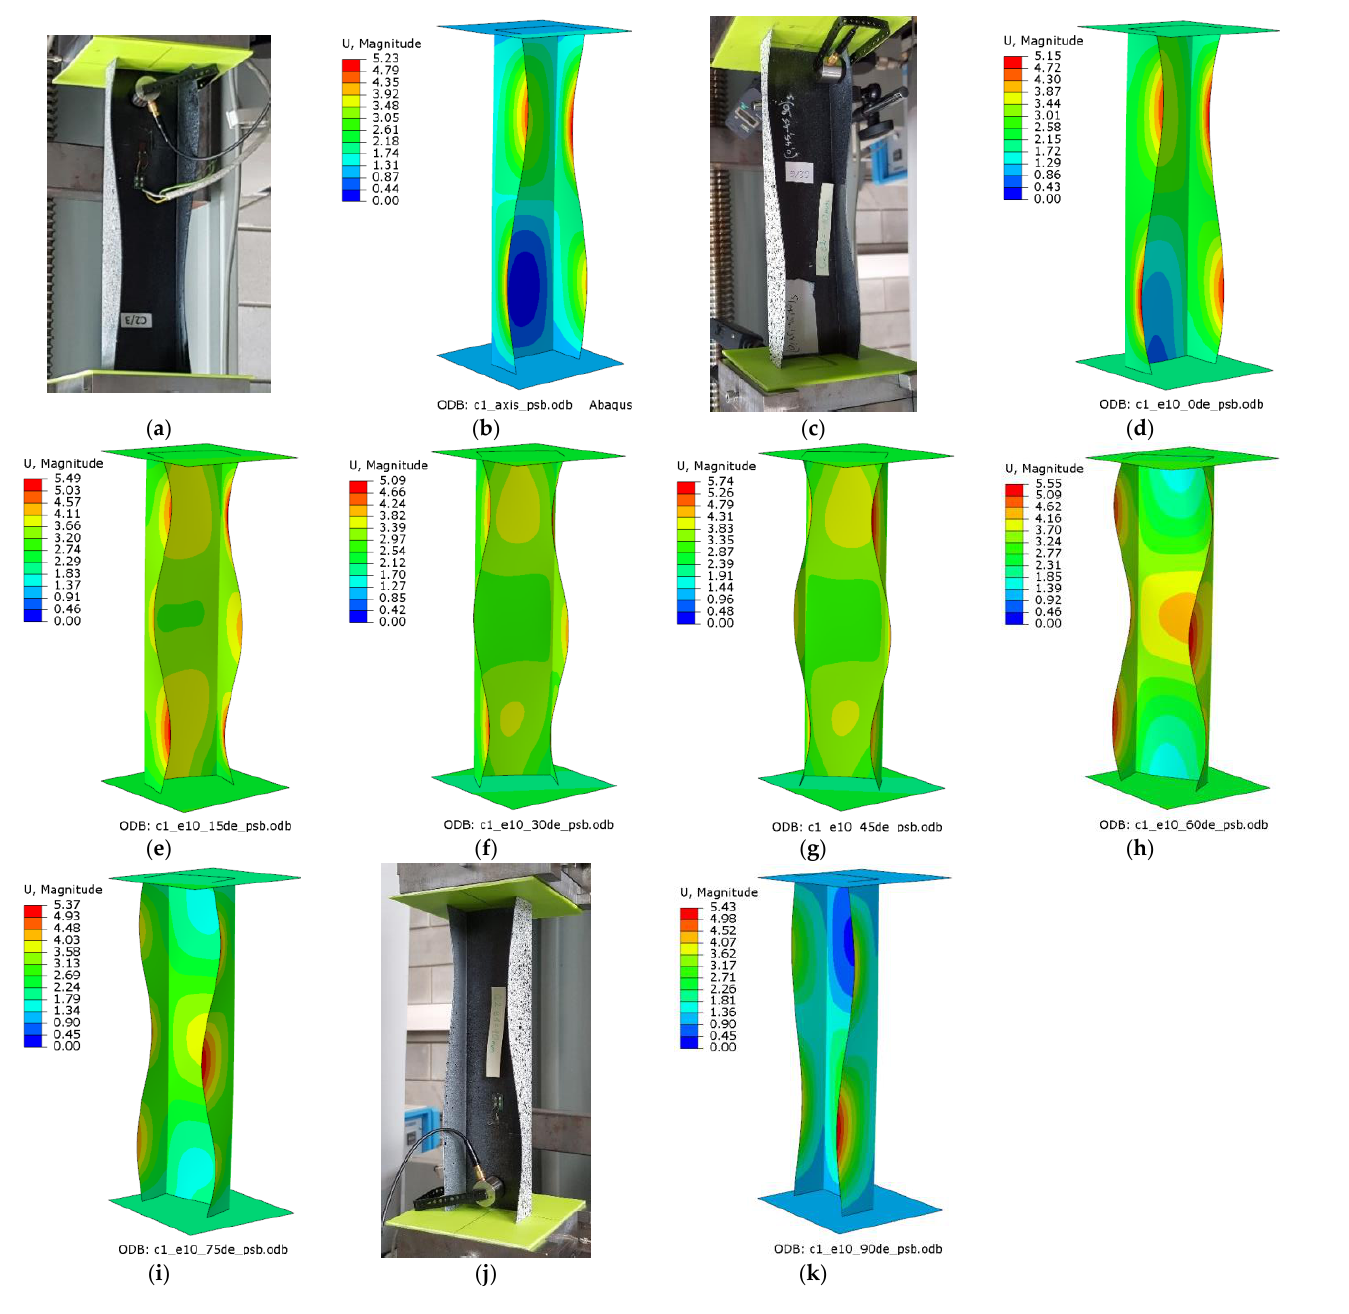
Figure 16. Early postbuckling modes for C1 [0/45/ − 45/90] s : ( a ) axis EXP, ( b ) axis FEM, ( c ) e10_0° EXP, ( d ) e10_0° FEM, ( e ) e10_15° FEM, ( f ) e10_30° FEM, ( g ) e10_45° FEM, ( h ) e10_60° FEM, ( i ) e10_75° FEM, ( j ) e10_90° EXP, ( k ) e10_90° FEM.